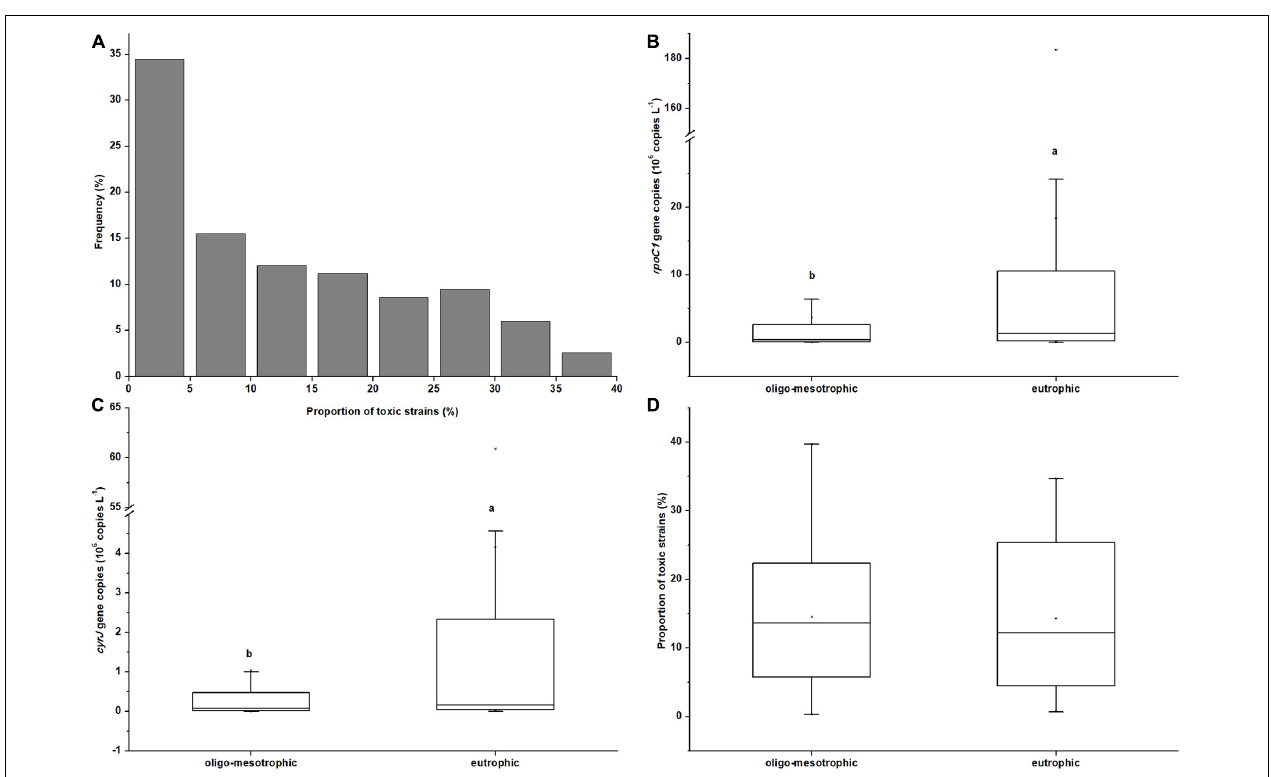
FIGURE 2 | Histograms plot showing the summary statistics of proportion of toxic strains ( cyrJ / rpoC1 ) within R. raciborskii population in 115 sampled reservoirs (A) ; Box-whisker chart showing the summary statistics of total abundances of R. raciborskii (B , rpoC1 gene copies ) , the abundances of its CYN-producing stains (C , cyrJ gene copies ) and the proportion of toxic strains within R. raciborskii population (D , cyrJ/rpoC1 ) under oligo-mesotrophic ( n = 78) and eutrophic ( n = 37) (sub)tropical reservoirs in southern China. Letters denote significant differences between the two types of reservoirs.